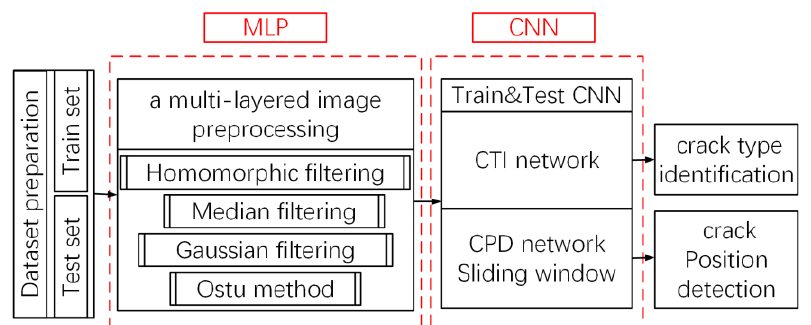
Figure 1. Diagram of the overall architecture of the MLP–CNN framework.